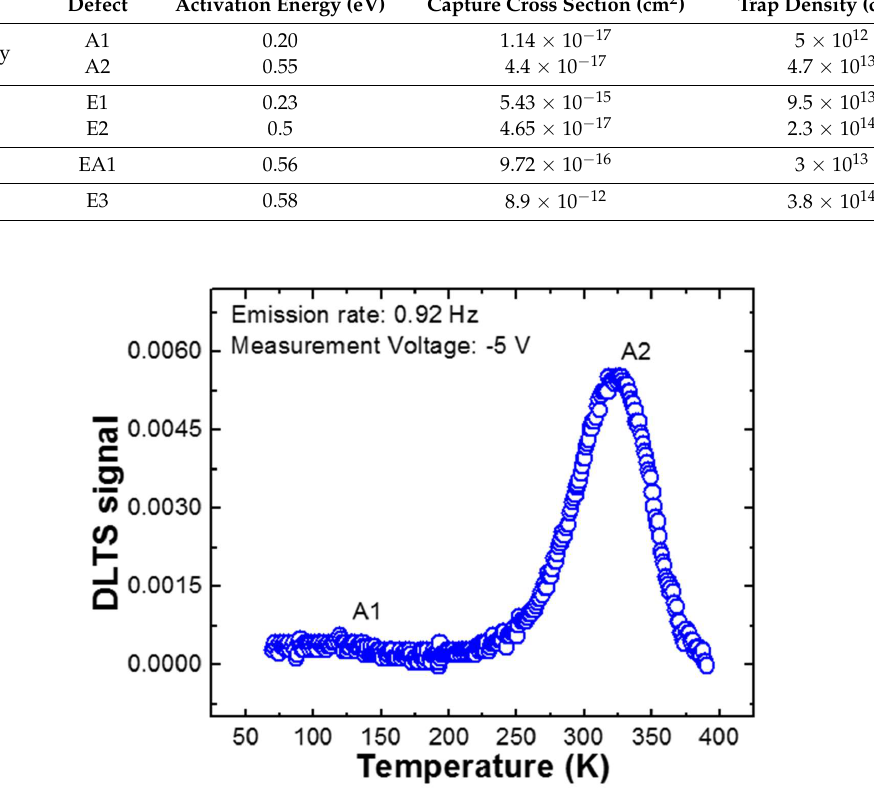
Figure 4. Deep-level transient spectroscopy (DLTS) spectrum of Au/HVPE a-plane GaN template Schottky diodes grown via in situ nanodot formation, measured at a reverse voltage of − 5 V in the temperature range of 70–370 K.